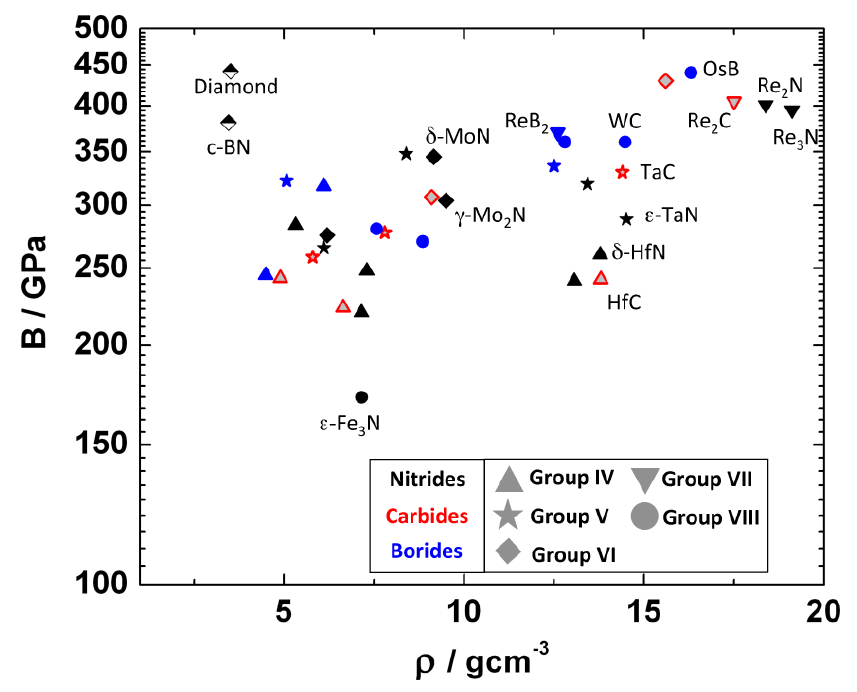
Figure 21. Plot of the bulk moduli of binary transition metal carbides, nitrides and borides versus density in comparison with cubic BN and diamond.